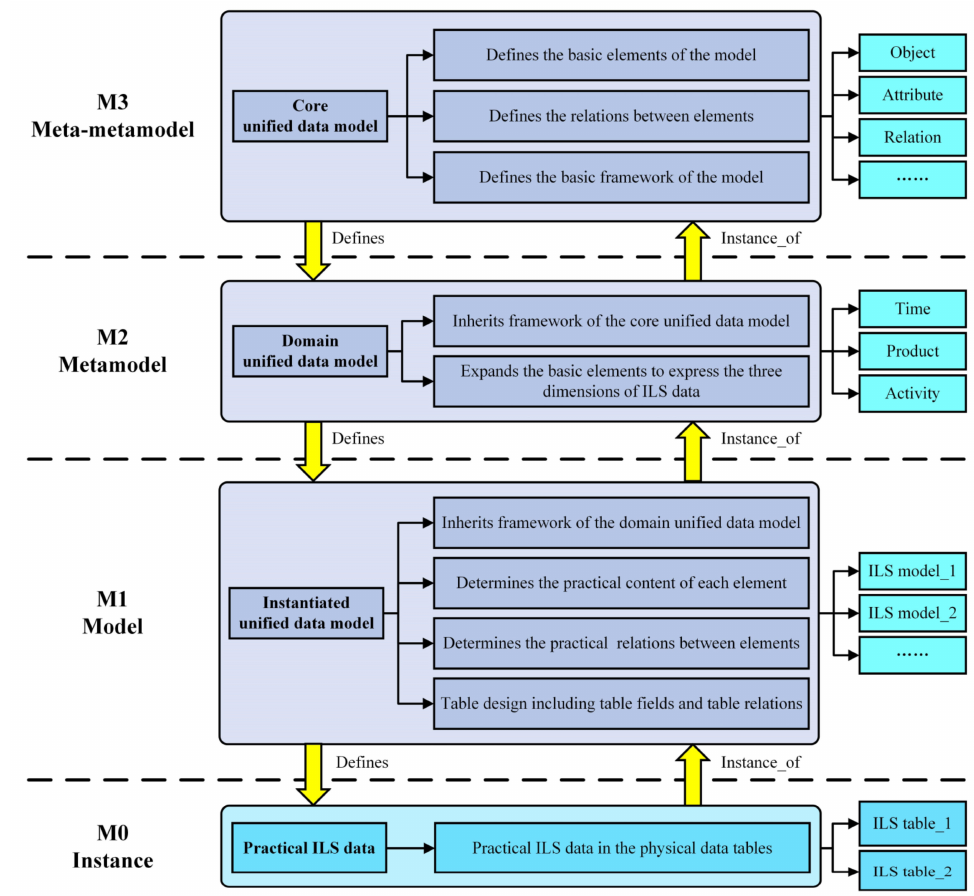
Figure 4. Four tier ILS unified data model